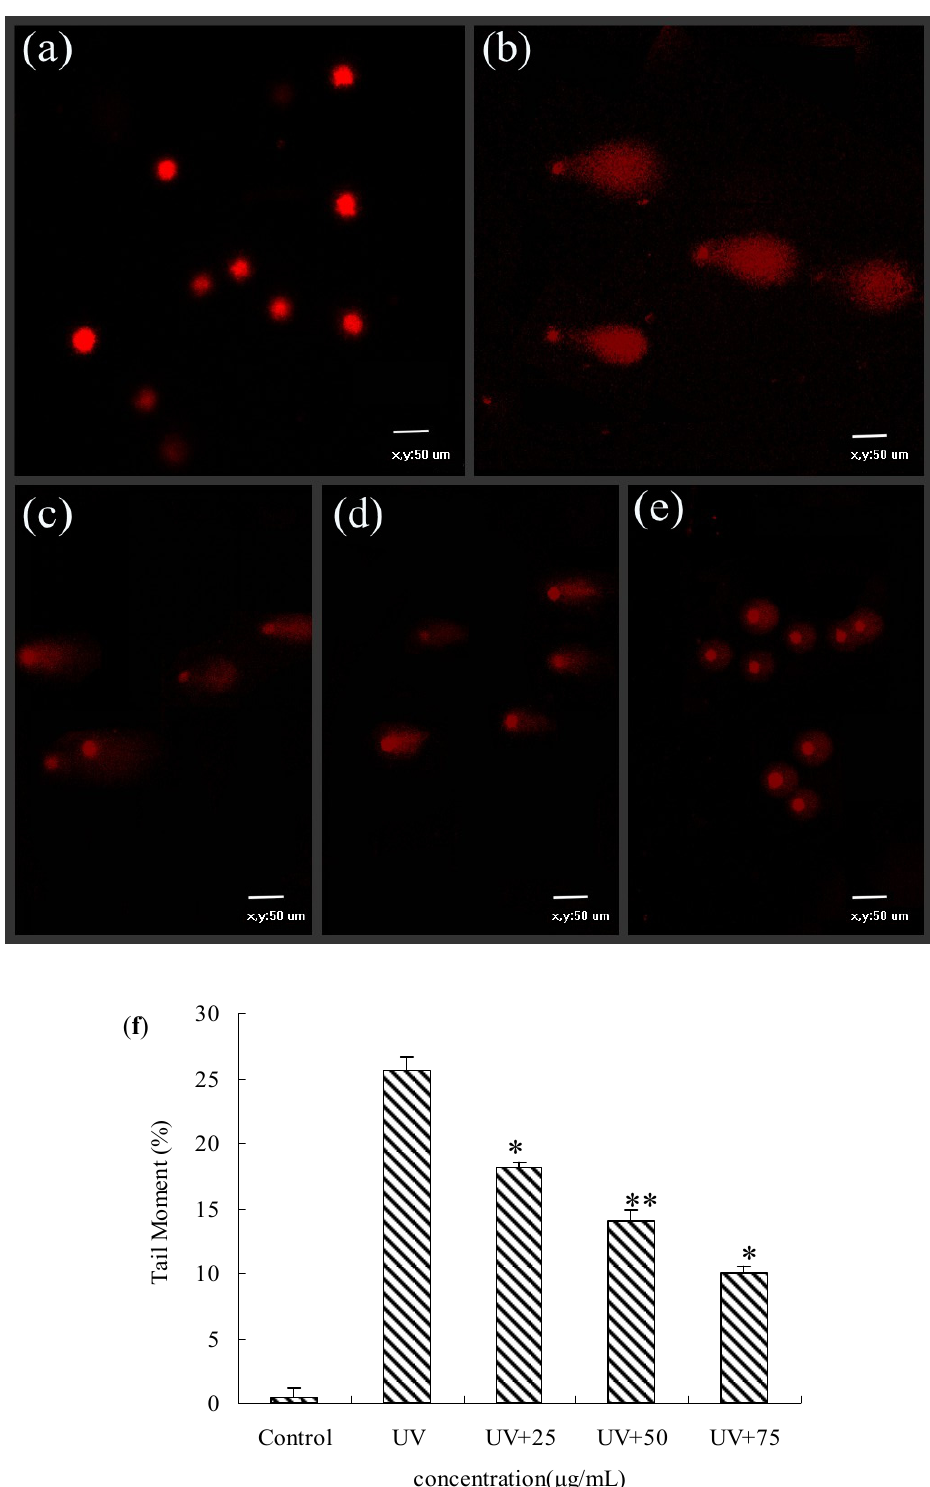
Figure 6. Evaluation of protection by BA extracts against UV-induced DNA damage detected by comet assay. HepG2 cells were pre-treated for 12 h with BA and then exposed to UV. ( a ) control (without UV radiation); ( b ) UV-radiation without extracts; ( c , d , and e ) were UV+ 25 μ g/mL BA, UV+ 50 μ g/mL BA, UV+ 75 μ g/mL BA; ( f ) quantification of DNA damage was analyzed by CASP software. Each value represents the mean of three experiments. * p < 0.05, ** p < 0.01, compared with the UV